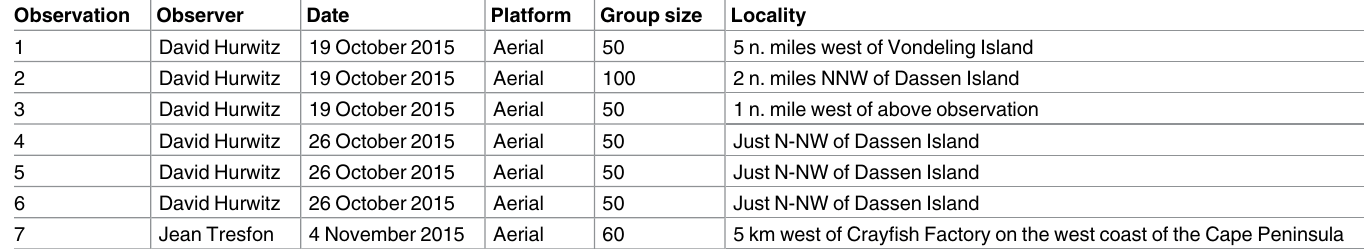
Table 2. Incidental observations of “super-groups” made by the public in the southern Benguela in 2011, 2014 and 2015. All of these observations were made at altitudes exceeding300m.